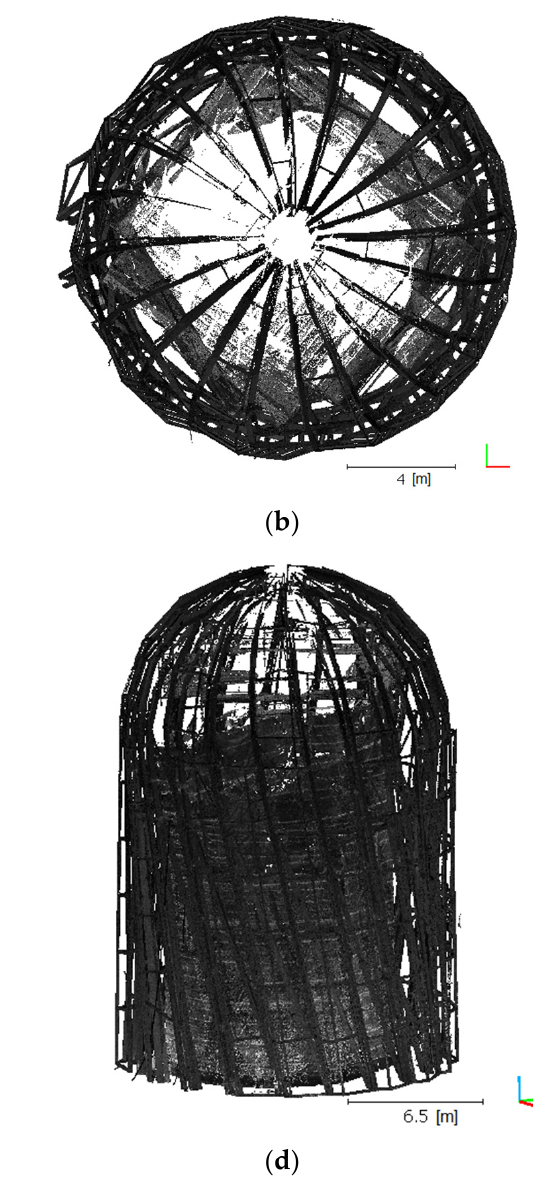
Figure 8. Post-filtration point clouds for UAV: ( a ) top view, ( c ) side view and TLS, ( b ) top view, and ( d ) side view. Table 4. Number of points in the individual clouds, after each filtration stage.